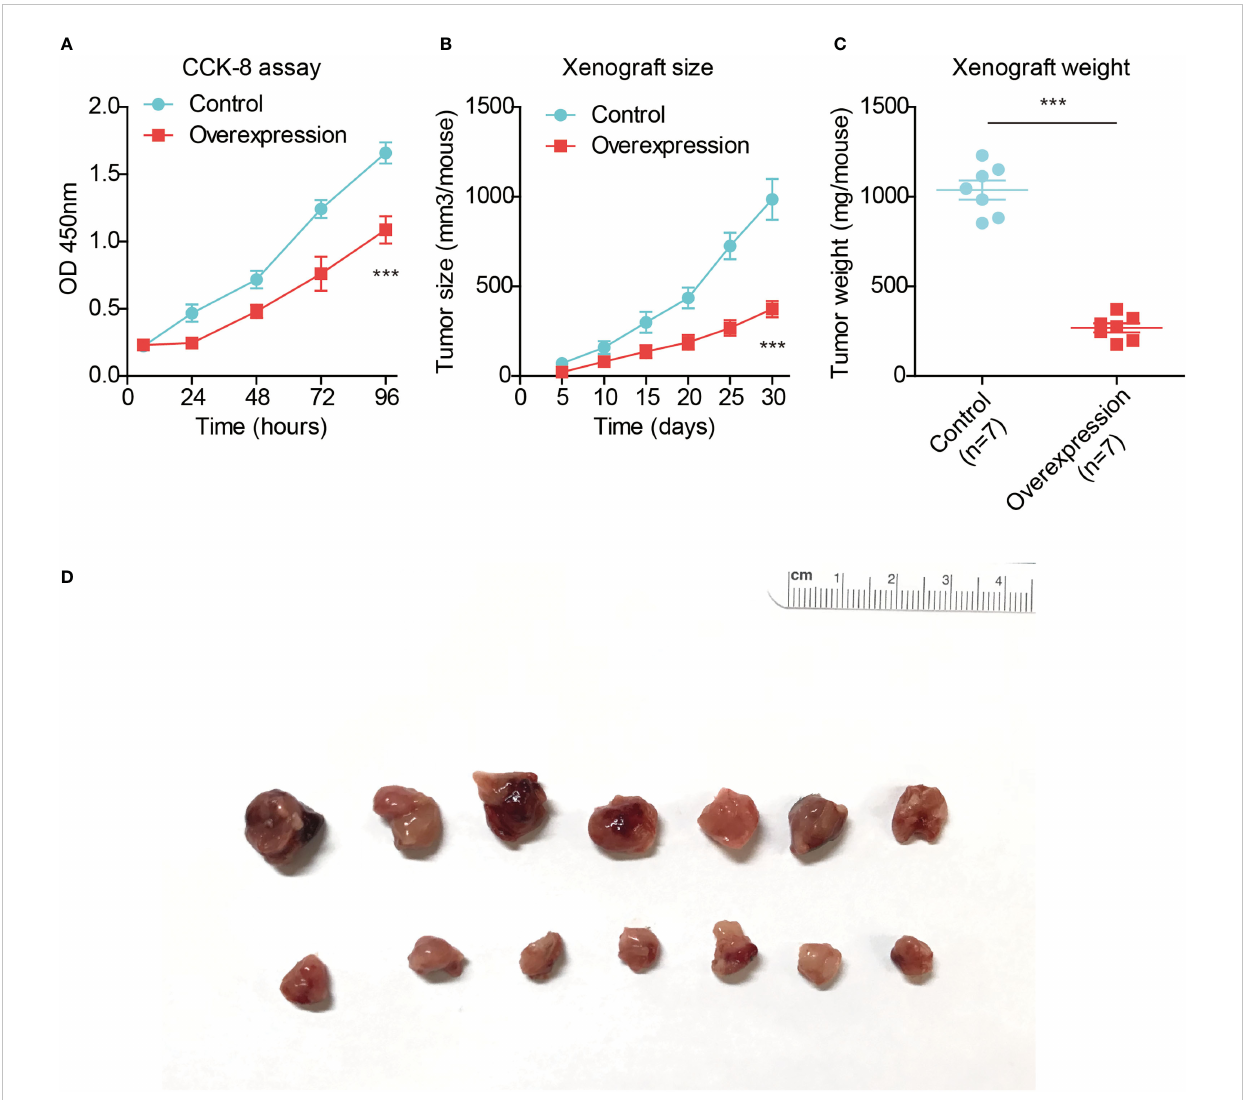
FIGURE 6 TMEM88 suppressed HCC progression both in vitro and in vivo . (A) CCK-8 assay was conducted to test the proliferation capacity of TMEM88- overexpressed HCC cells and control cells. (B) Growth curve of mice subcutaneous xenografts were monitored and recorded. (C) The tumor weights of isolated xenografts were tested and compared in the two groups. (D) The photographed images of resected xenografts from nude mice.